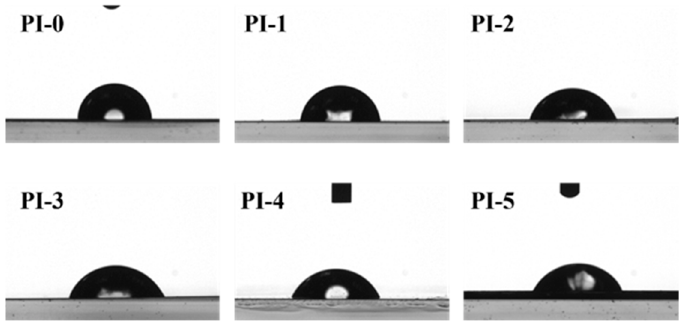
Figure 5. The contact angle of